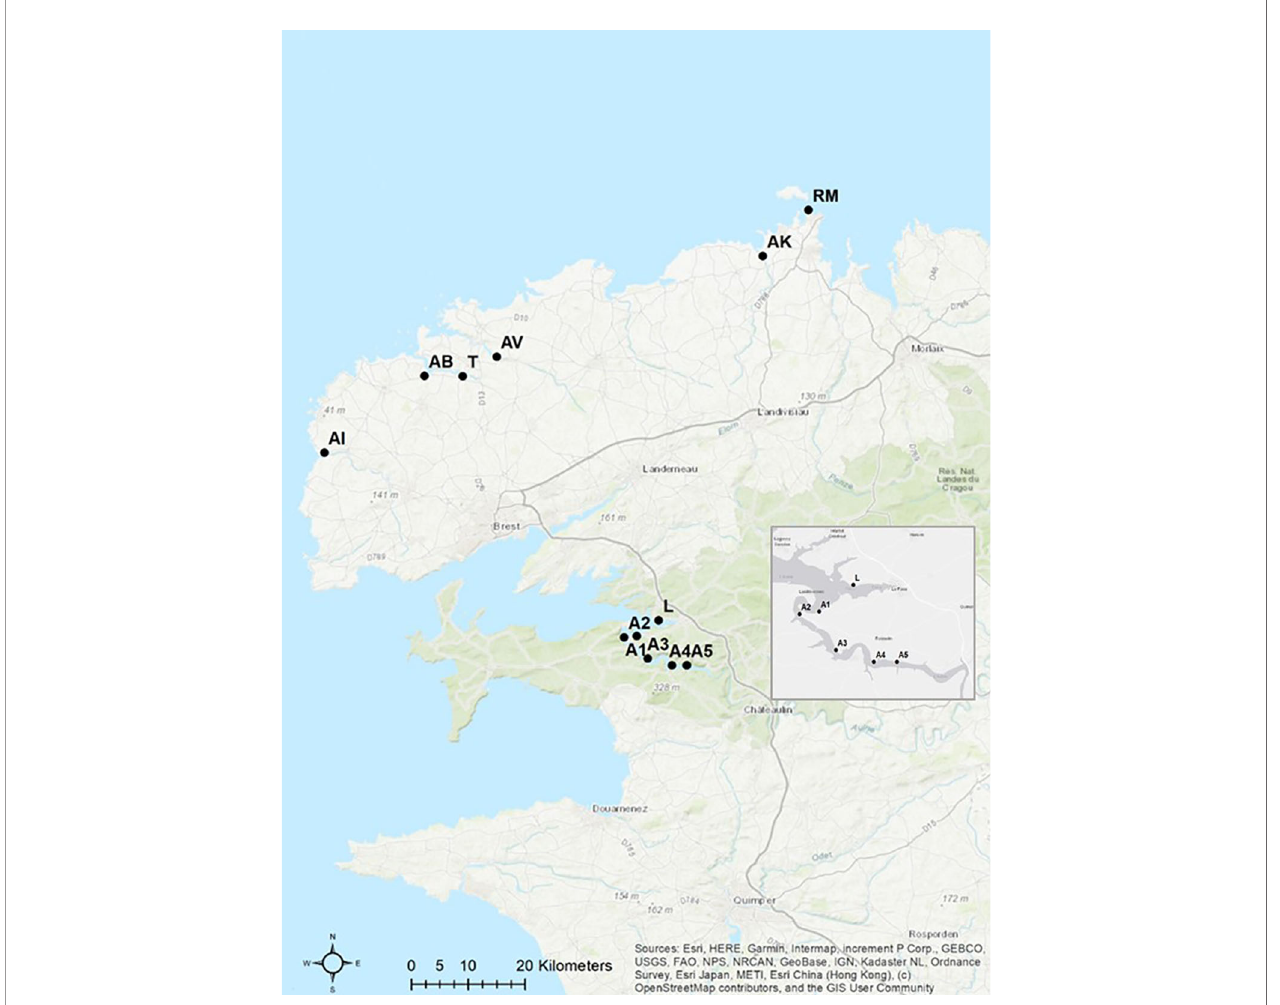
FIGURE 1 | Long-term monitoring 2012-2020. Sampling sites in north-west Brittany (map modi fi ed from ArcGis, Table 1 for